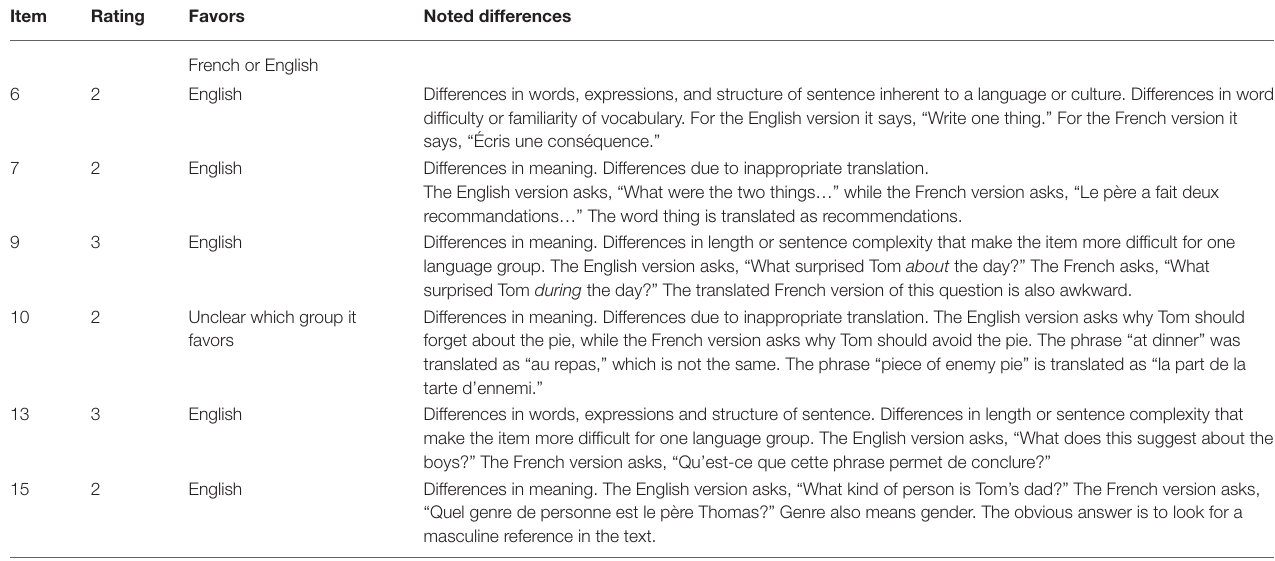
TABLE 7 | Passage 3 “Enemy Pie” expert review ratings and noted differences.